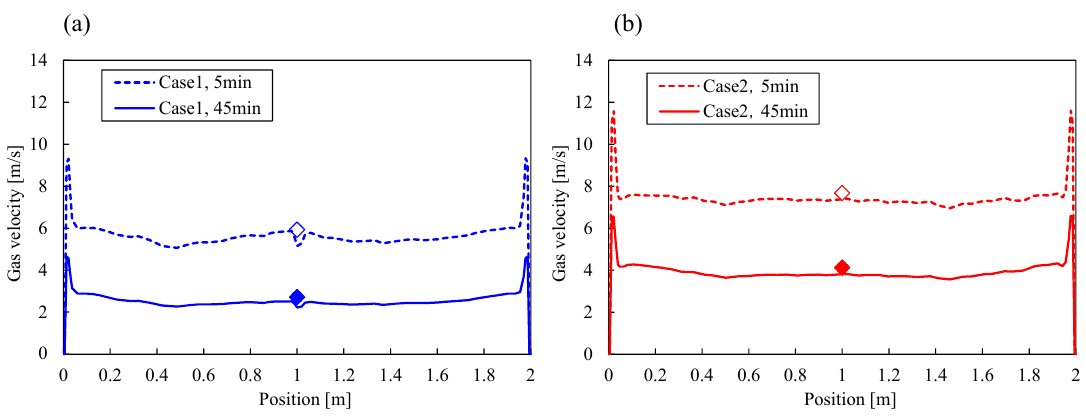
Figure 14. Calculated gas velocity distribution at top of slag packed bed: (a) Case 1, (b) Case 2, ◊ : Average value at 5 min, ♦ : Average value at 45 min.